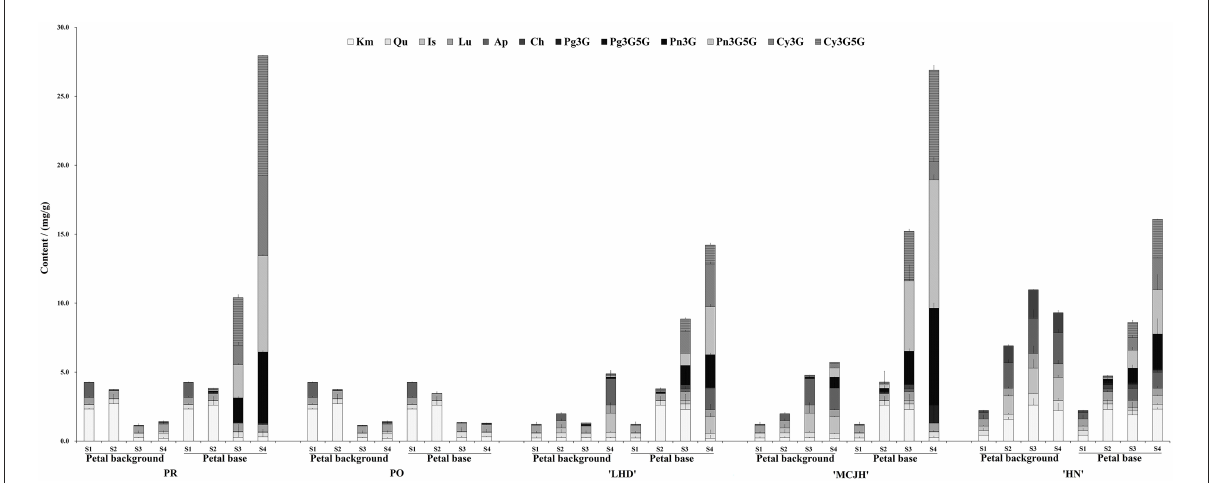
FIGURE2 The contents of flavonoids in petal background and base of P. rockii (PR), P. ostii (PO), and three tree peony cultivars “Lanhudie” (LHD), “Mochi Jinhui” (MCJH), and “High Noon” (HN) during petal spot formation. S1–S4 represent four different blooming stages. Cy3G, cyanidin 3-O-glucoside; Cy3G5G, cyanidin 3, 5-O-glucoside; Pg3G, pelargonidin 3-O-glucoside; Pg3G5G, pelargonidin 3, 5-O-glucoside; Pn3G, peonidin 3-O-glucoside; Pn3G5G, peonidin 3, 5-O-glucoside; Km, kaempferol; Qu, quercetin; Lu, luteolin; Is, isorhamnetin; Ap, apigenin; Ch, chrysoeriol.